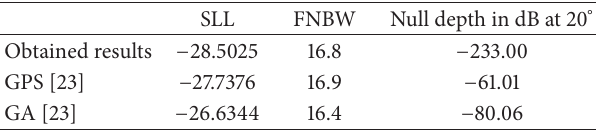
Figure 4: The normalized radiation pattern of 20-element linear